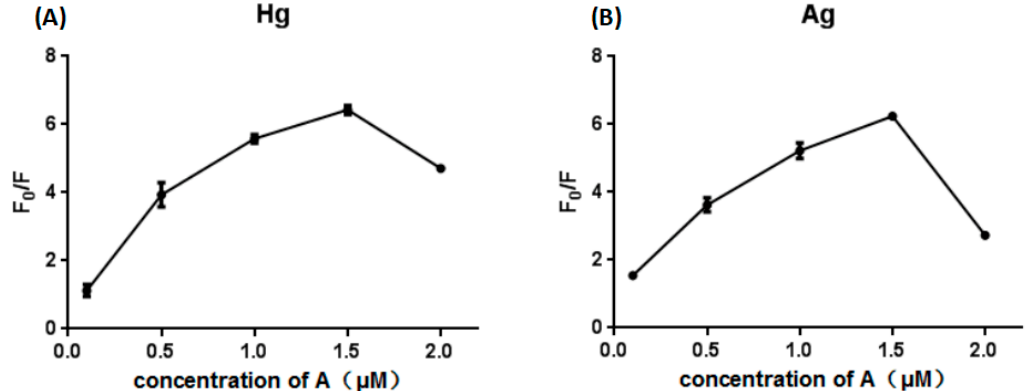
Figure 3. Optimization of concentration of A stand in the presence of Hg 2+ ( A ). Optimization of concentration of A stand in the presence of Ag + ( B ).